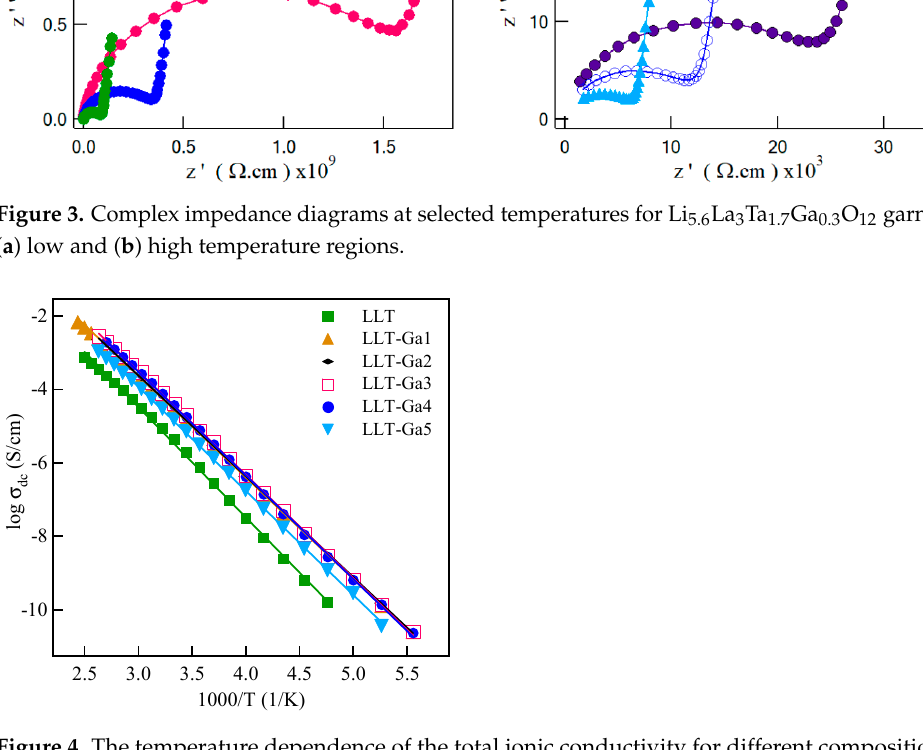
Figure 4. The temperature dependence of the total ionic conductivity for different compositions of Li 5+2x La 3 Ta 2-x Ga x O 12 garnets along with the pure Li 5 La 3 Ta 2 O 12 . The values of σ (cid:2914)(cid:2913) at 300 K of Li 5+2x La 3 Ta 2-x Ga x O 12 ceramics are summarized in Table 1.